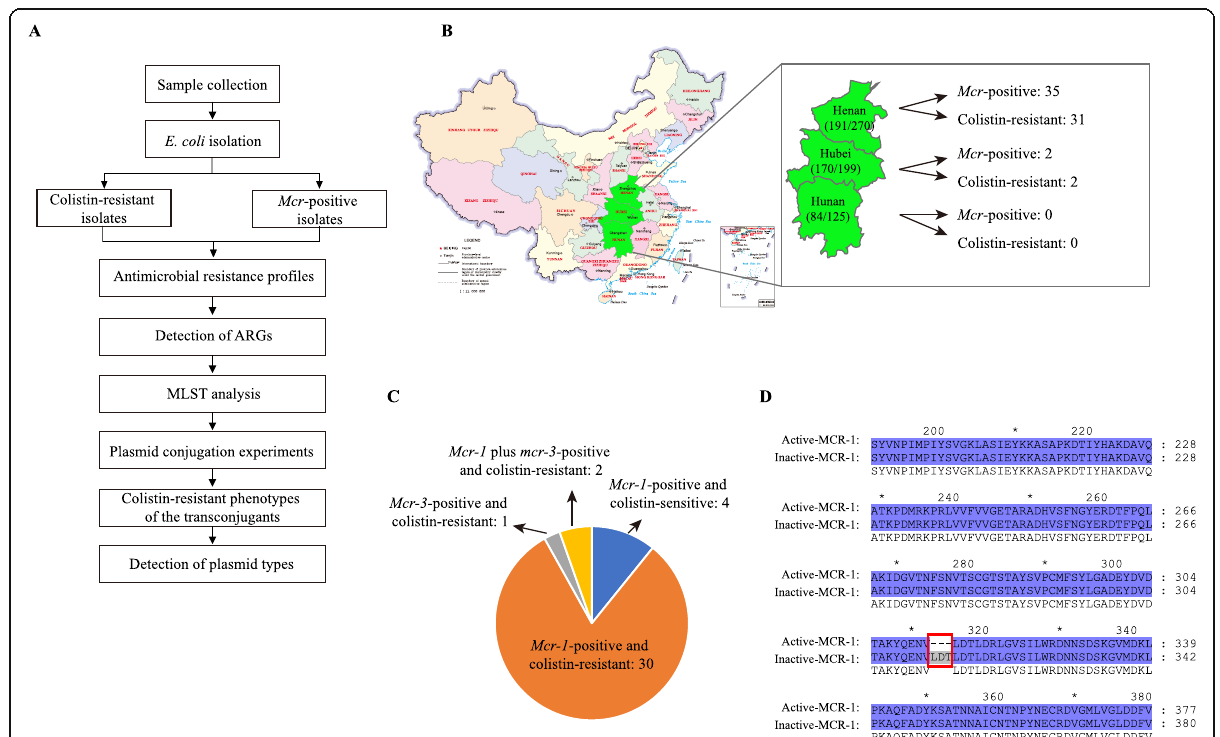
Fig. 1 Sample collection and bacterial isolation. A Flow chart showing the study design. B A map of China showing the sample collection regions (marked in red, censor code of this map: GS (2019)1684). In each provinces, the numbers of E. coli isolates (numerator) and samples collected (denominator) as well as the numbers of mcr -positive isolates and colistin-resistant isolates are shown. C Pie chart showing the numbers of E. coli isolates with different molecular and phenotypic characteristics ( mcr -positive and colistin-resistant or mcr -positive but colistin- sensitive). D Alignment of amino acid sequences of the protein encoded by mcr -1 in mcr -positive and colistin-resistant isolates (marked as Active- MCR-1) and mcr -positive but colistin-sensitive isolates (marked as Inactive-MCR-1); amino acid sites where mutations occur are marked with red